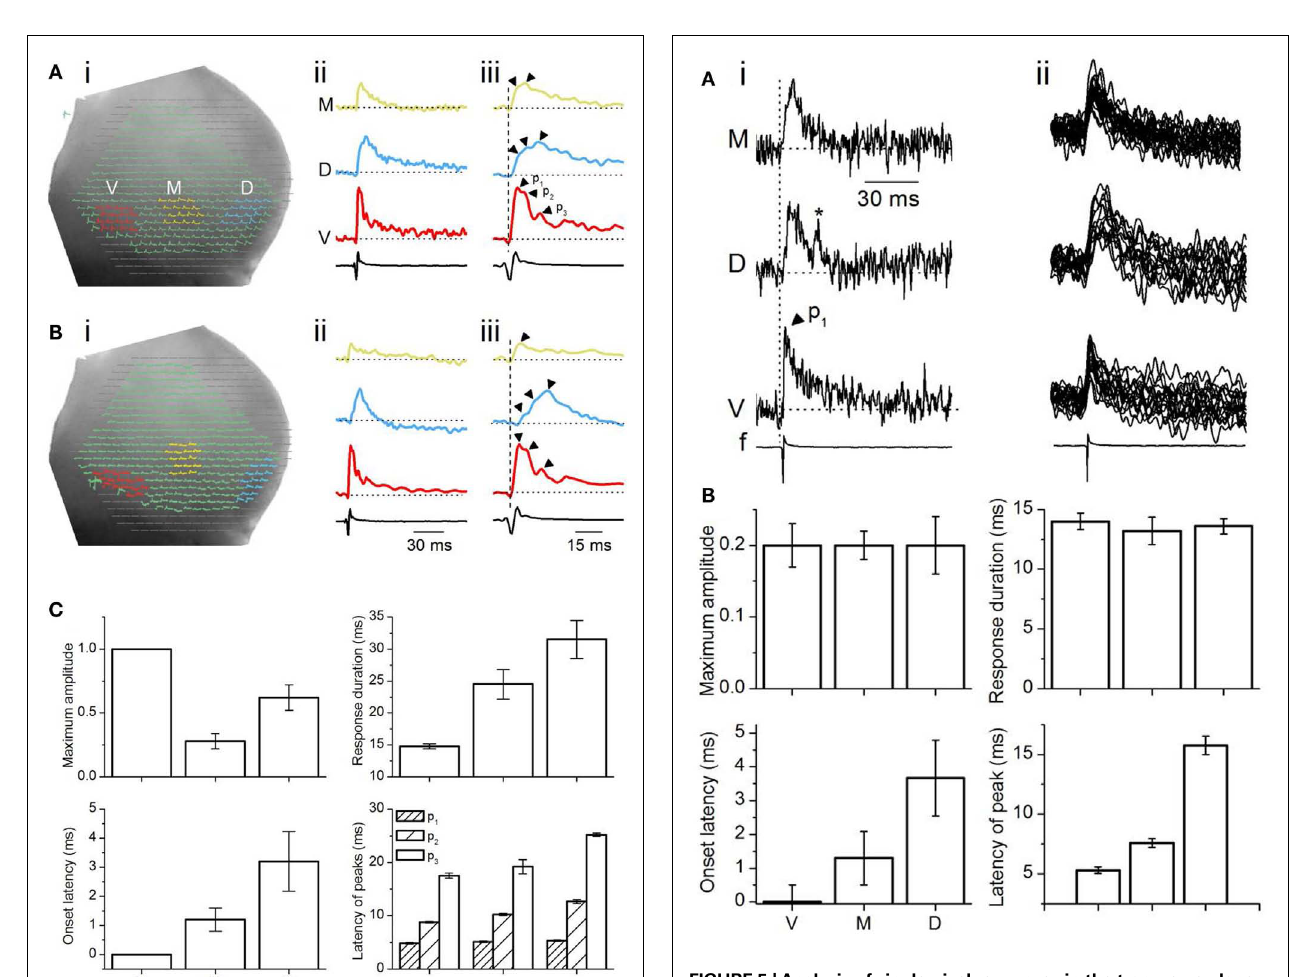
FIGURE 5 |Analysis of single-pixel responses in the transverse plane. (A ) (i) LL-evoked responses in single pixels from different ICC regions. M, medial; D, dorsal;V, ventral ICC; f , field recording.Vertical dotted line, time of response onset in the ventral ICC; p 1 , single-peak; Asterisk, spontaneous event. (ii) Superimposed traces from 16 single pixels in each region illustrated for the same slice as (i).The 16pixels picked are the same ones used for multi-pixel analysis. (B) Single-pixel measures of maximum amplitudes, duration of response, onset latency, and time of single-peak. Maximum amplitudes are depicted as fractions of the maximum amplitude of the multi-pixel response in the ventral ICC. Response durations were absolute values, measured at half-maximum amplitude. Onset latencies were measured with respect to the onset of the multi-pixel peak response in the ventral ICC, which was set to zero. Peak time of responses in individual pixels was measured with respect to the average single-pixel onset latency in each region. Averages are from the 16pixels used for multi-pixel analysis in each region of the slice. Each point is the average of three to four trials from each slice, further averaged over 26 slices. Error bars are